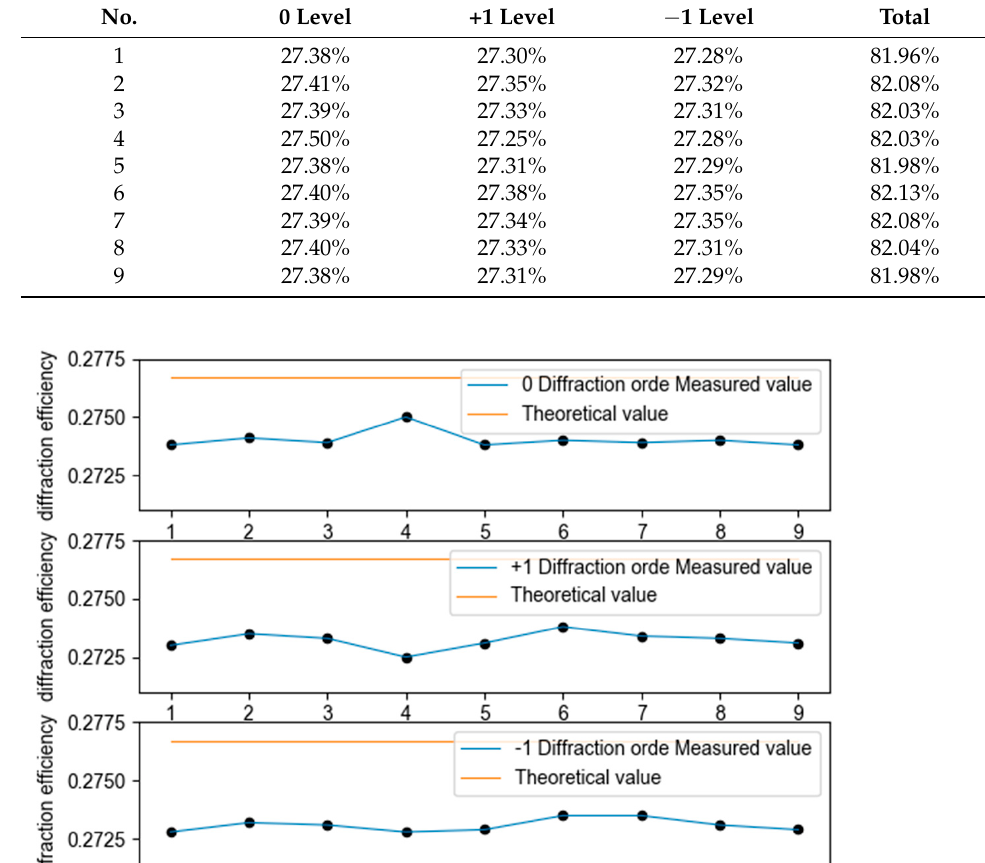
Figure 12. Comparison of theoretical and measured values of diffraction efficiency for different dif- fraction stages. 4.2. Imaging Experimental Analysis The simulation results of the imaging in VirtualLab Fusion are shown in Figure 13. As shown in Figure 13, the images acquired after the improvement based on this method are significantly improved in terms of the accuracy of imaging and uniformity of intensity compared with the three objects.